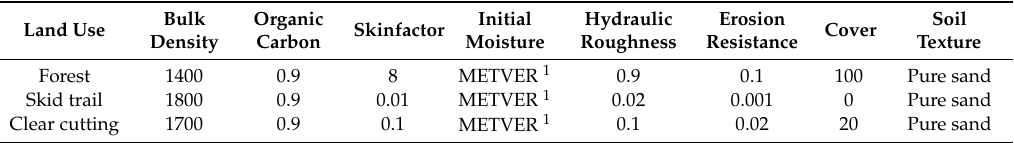
Table 3. The parameterization of a disturbed